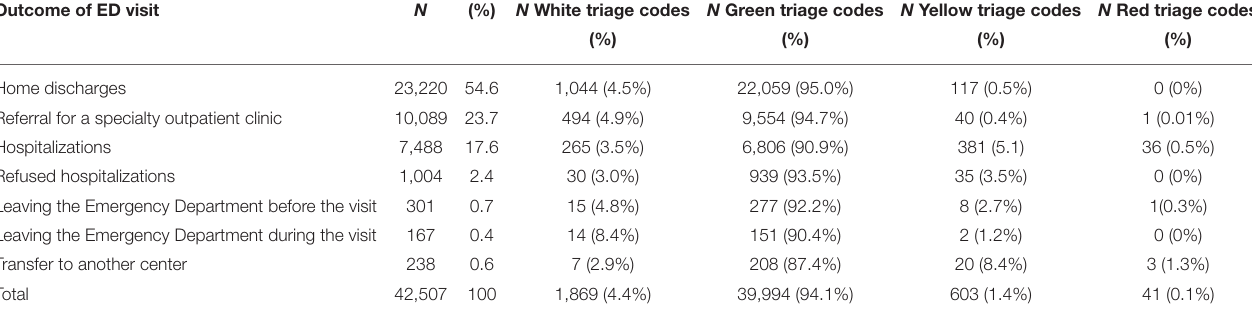
TABLE 1 | Outcomes of pediatric Emergency Department visits during years 2014–2019 according to triage codes. Outcome of ED